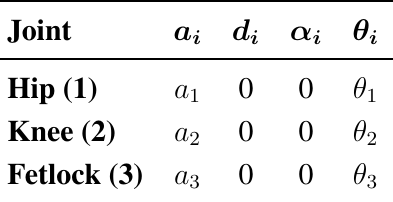
Table 4. Denavit–Hartenberg parameters of the leg model.